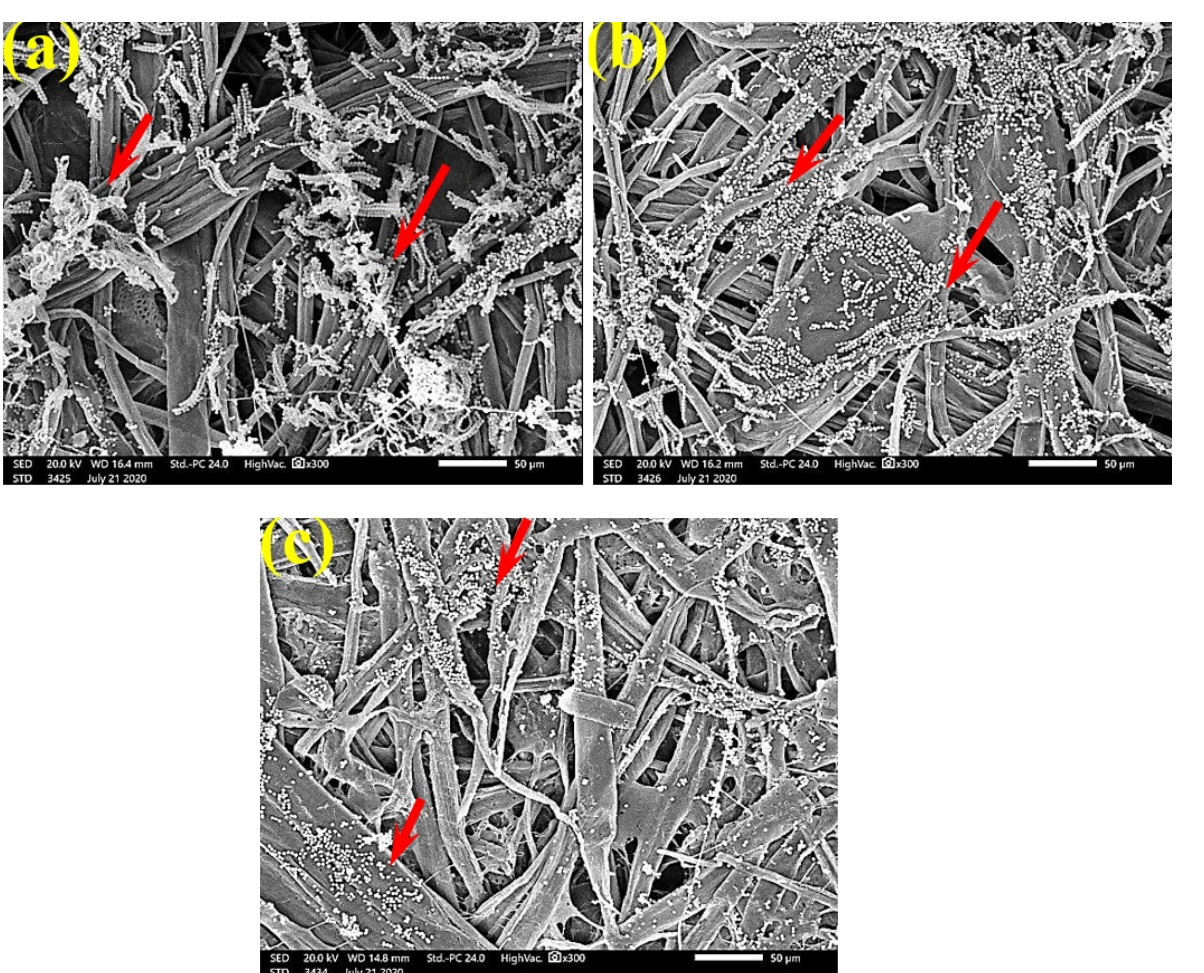
Figure 7. SEM images of paper sheets manufactured from pulps of ( a ) B. speclabilis , ( b ) F. altissima , and ( c ) F. elastica treated with 0.25% MAHE and inoculated with A. fumigatus . Arrows refer to dense growth of fungal mycelia based on the concentration of the extract and the type of paper sheet pulp.